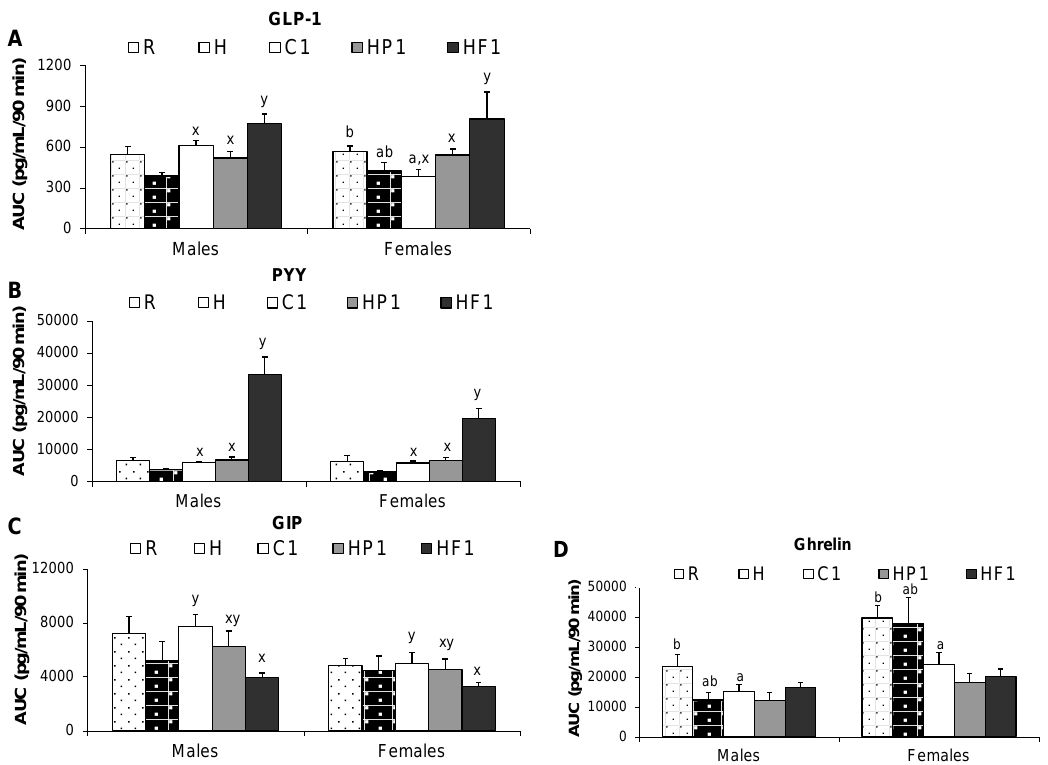
Figure 5. Area under the curve for GLP-1 ( A ), PYY ( B ), GIP ( C ) and ghrelin ( D ) over a 90 min OGTT at 28 weeks. Values are means ± SEM, n = 10 per group except n = 4 for group H. Treatments with different letters are significantly different between diets: superscripts x,y indicate significant difference between C1, HP1, HF1; superscripts a,b indicate significant difference between R, H and C1 ( p < 0.05).